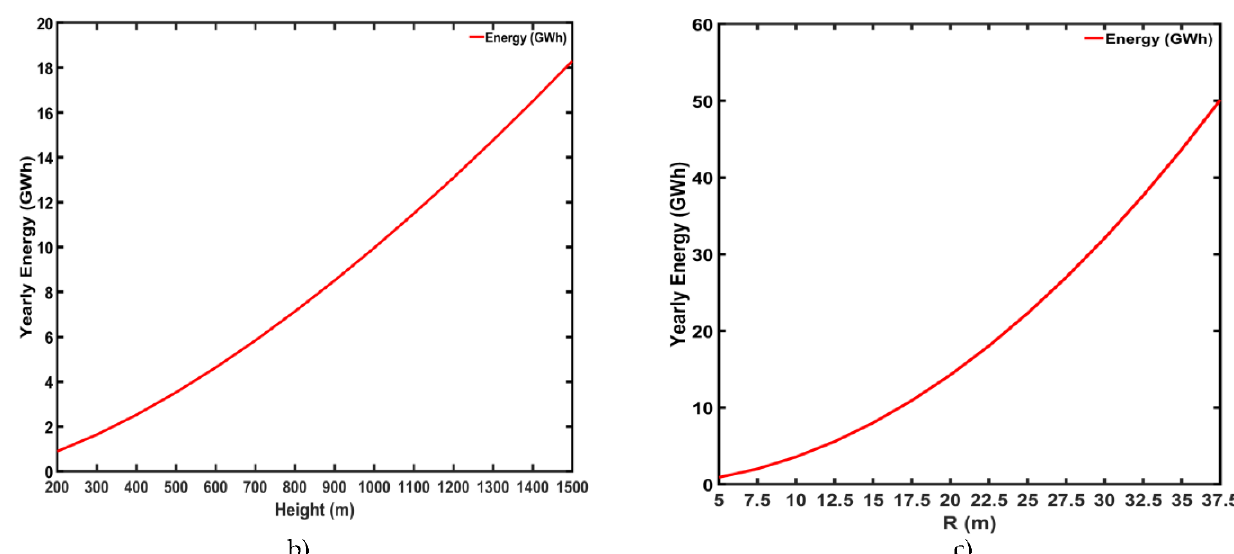
Figure 7. System metrics: ( a ) system efficiency ratio of the proposed SDCPP vs. the traditional SCPP, ( b ) yearly electrical energy production as a function of chimney height, ( c ) yearly electrical energy production as a function of chimney diameter.